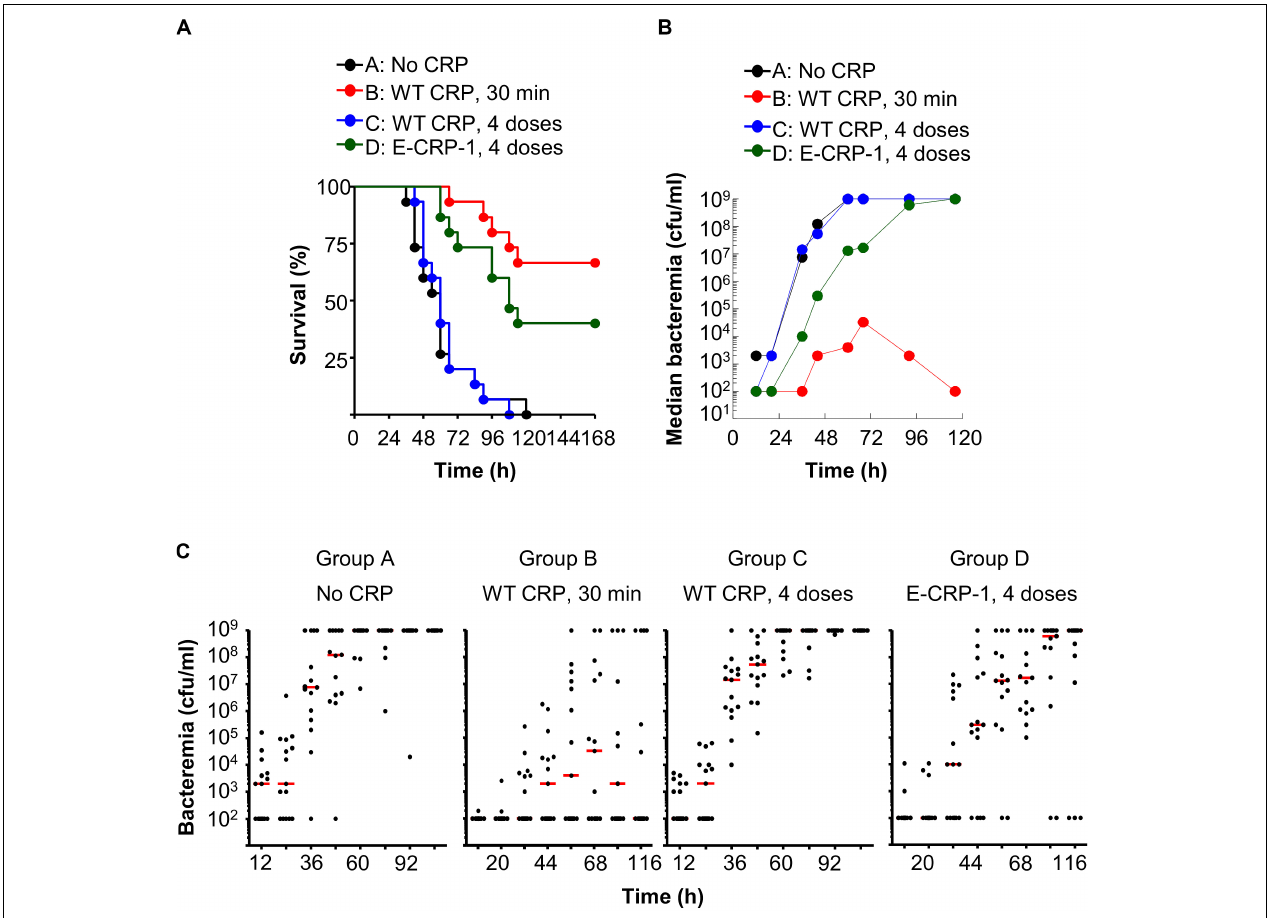
FIGURE 8 | One injection of E-CRP-1 was sufficient to protect against late-stage infection. The data are combined from two separate experiments with six to eight mice in each group in each experiment. (A) Survival curves. CRP was injected four times: 6, 12, 24 and 48 h after injecting pneumococci. The p -values for the differences in the survival curves between groups A B, A D, B C and C D were < 0.001. (B) Bacteremia. Blood was collected from each surviving mouse shown in A . The median bacteremia values are plotted. The p -value for the difference between groups A C was > 0.05 at all-time points. For 36–116 h, the p -value for the difference between groups B C was < 0.001. For 44–116 h, the p -values for the differences between groups B D and C D were < 0.05. For 44-116 h, the p -value for the difference between groups A D was < 0.01. (C) Scatter plots of the bacteremia data shown in B . The horizontal line in each group of mice represents median